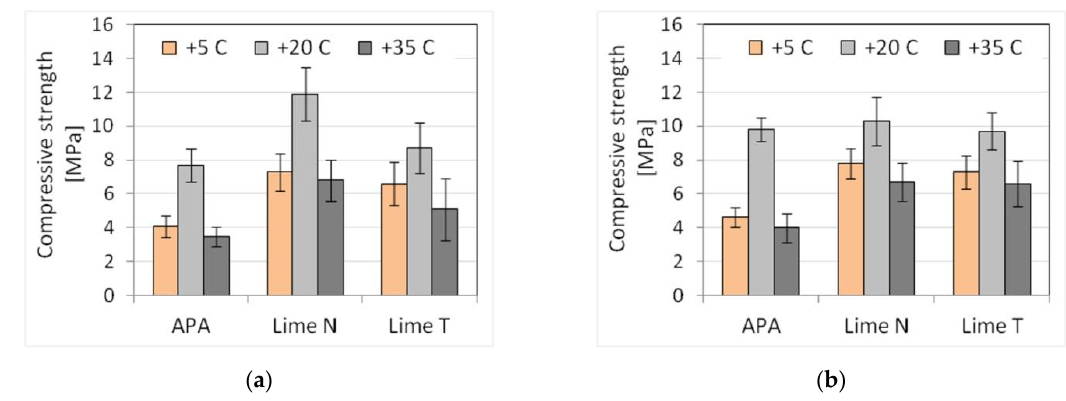
Figure 16. Influence of the temperature changes on the compressive strength of ( a ) plaster, ( b ) masonry mortars.